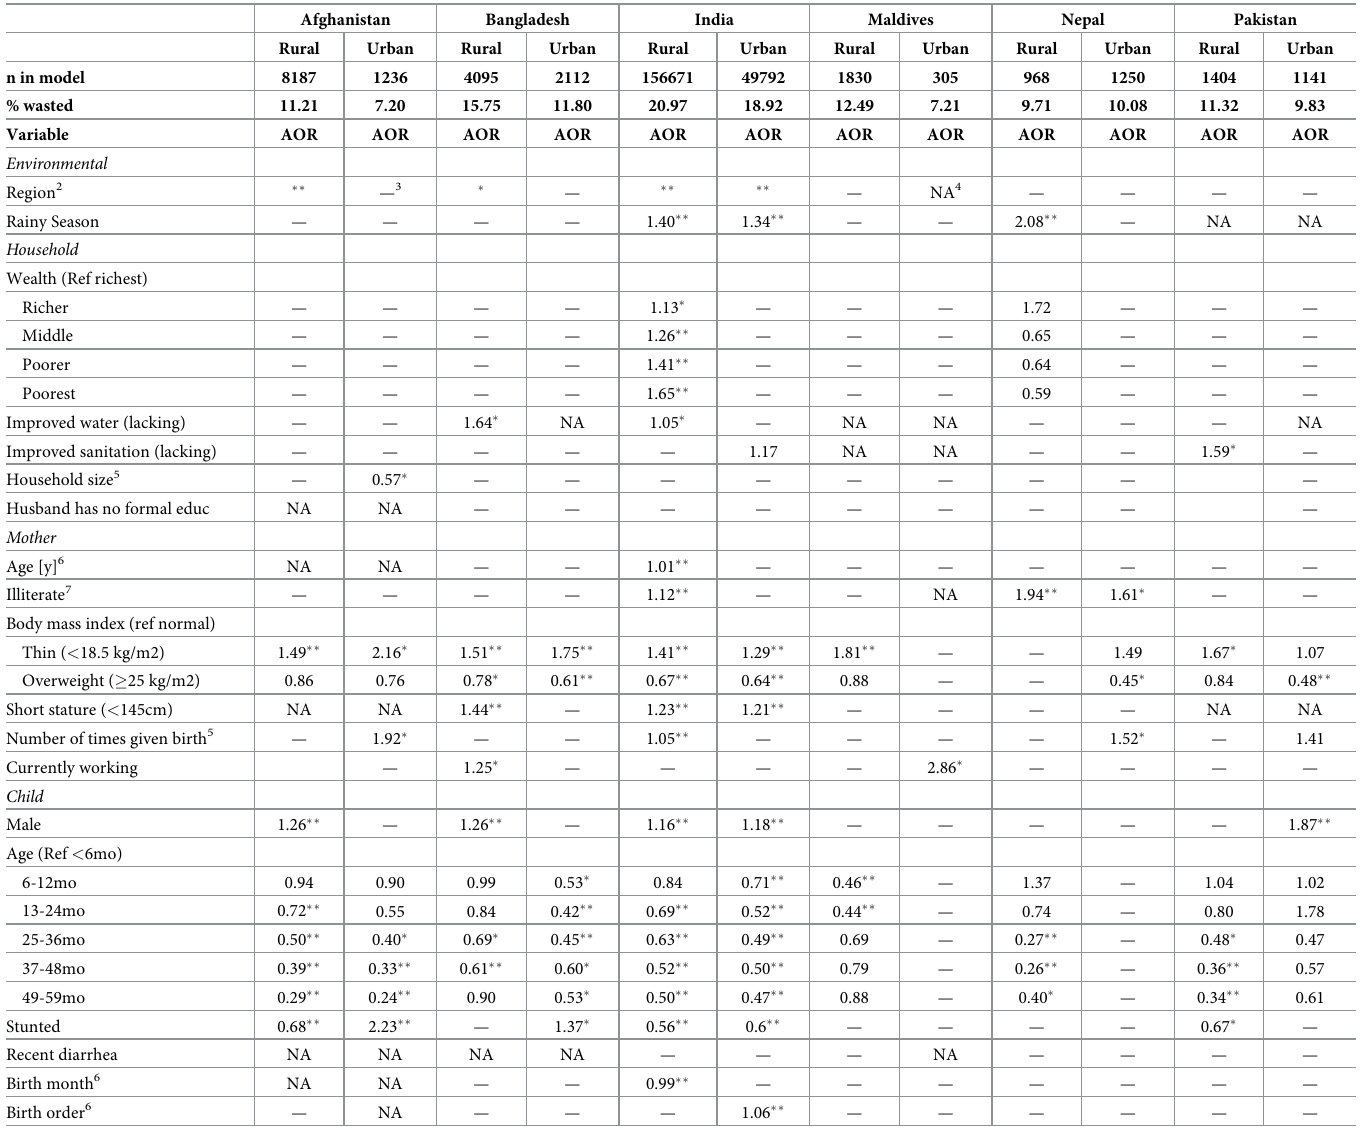
Table 4. Adjusted odds ratios (AORs) of wasting among children in South Asia and by rural and urban and by country 1 .